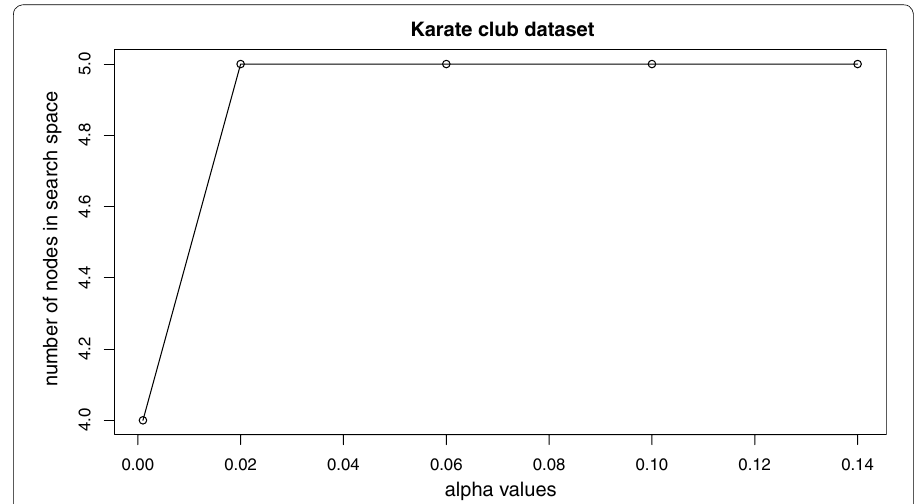
Fig. 2 Figure showing the relationship between α values and the number of nodes in search space